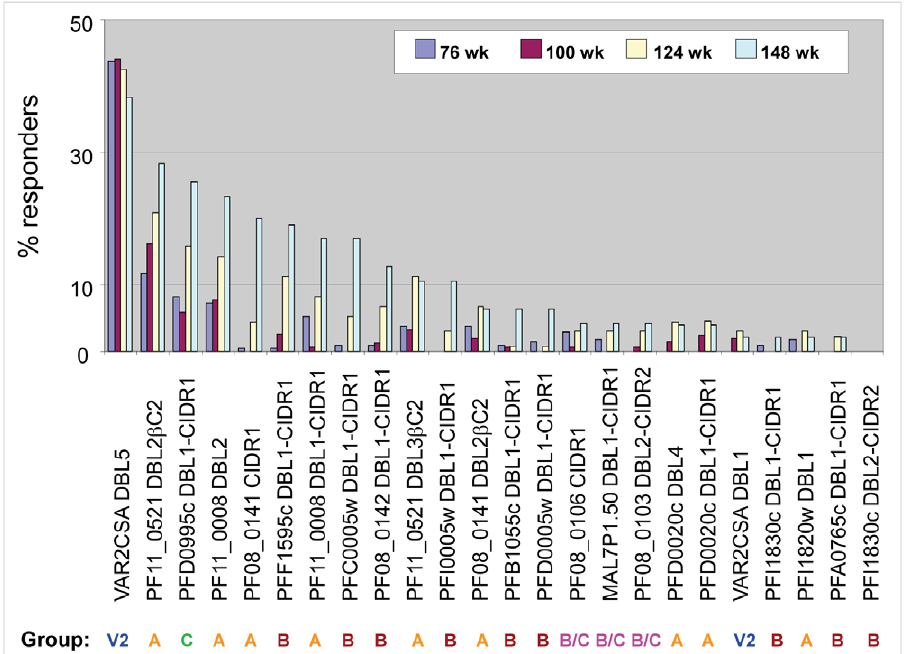
Figure 2. Prevalence of plasma IgG reactivity to individual PfEMP1 domains, stratified by age. Bars indicate the prevalence of plasma IgG reactivity among Tanzanian children of different ages to the indicated PfEMP1 constructs. PfEMP1 classification: V2 - VAR2CSA, A - group A, B - group B, C - group C, B/C - group B/C (according to [29]). As indicated in Figure 1 and Table 1, DBL1-containing constructs also contain N-terminal segment (NTS), but NTS is not included in the construct